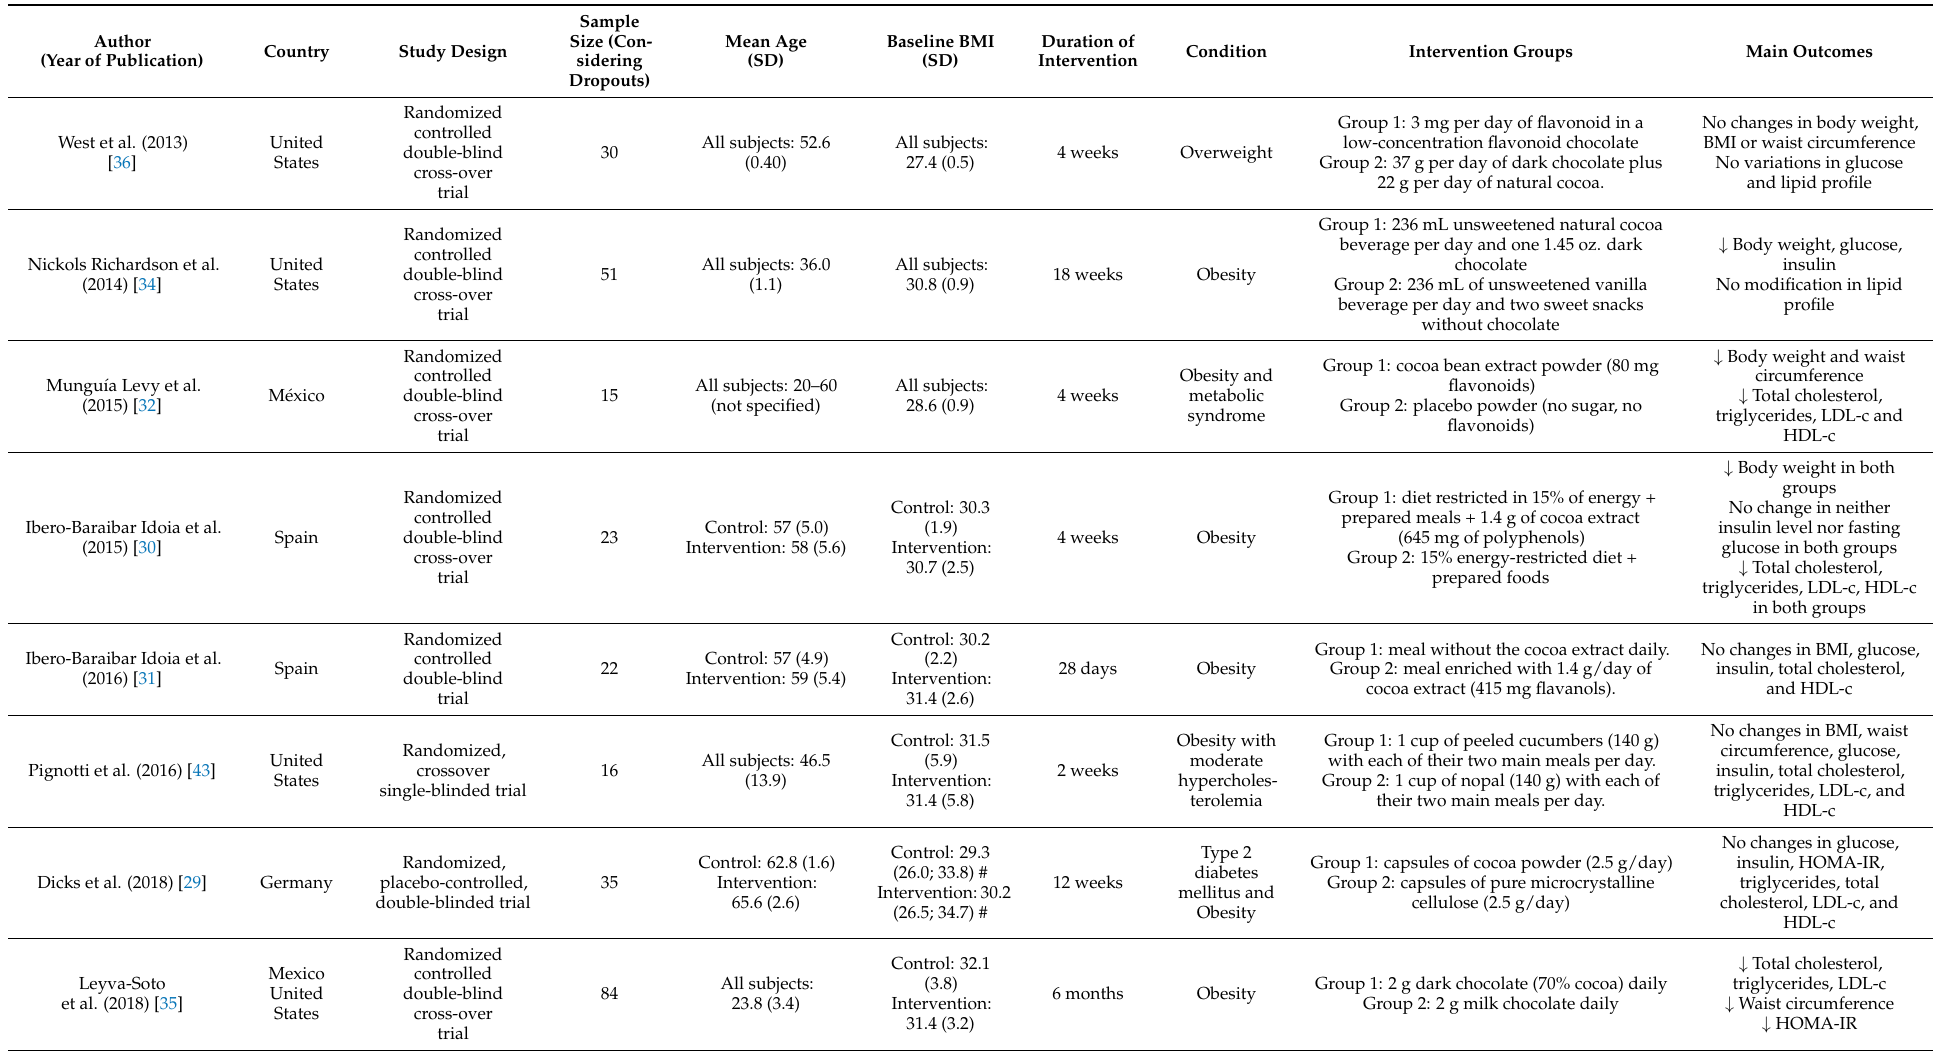
Table 2. Characteristics of included